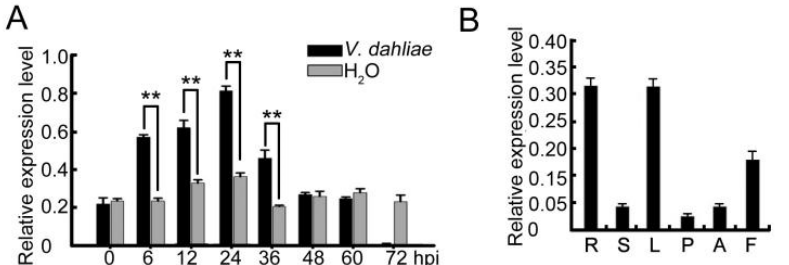
Figure 1. Expression analysis of cotton GhWLIM1C . ( A ) qRT-PCR analysis of GhWLIM1C expression in cotton roots in response to V. dahliae infection. Total RNA was extracted from cotton roots inoculated with V. dahliae spores (1 × 10 6 conidia/mL) for 0, 6, 12, 24, 36, 48, 60, and 72 h, respectively, and 0 h indicates cotton plants without inoculation with the fungal spores. Error bars represent SD from three independent experiments ( n = 3). Asterisks indicate statistically significant differences, as determined by Student ’ s t -test (** p < 0.01). The experiments were repeated three times with similar results. ( B ) qRT-PCR analysis of GhWLIM1C gene expression in root (R), stem (S), leaf (L), petal (P), anther (A), and fiber (F; 12 days post-anthesis) in cotton plants. The expression levels are indicated relative to cotton UBI gene. Error bars represent ± SE of three biological replicates.